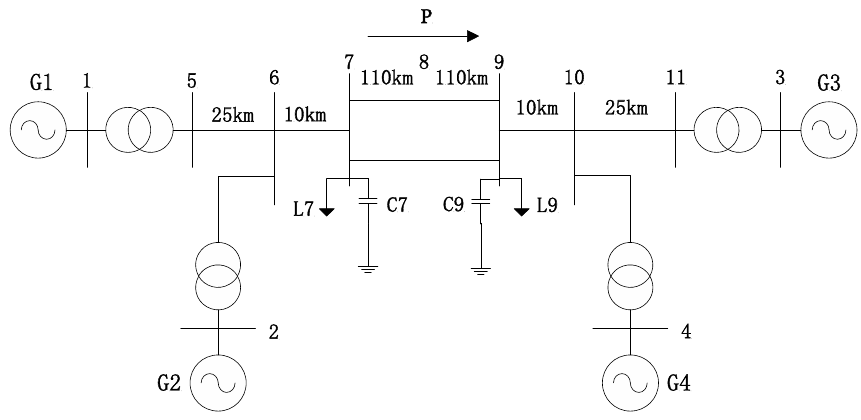
Figure 2. Power system with four machines in two areas. Table 1. The results of modal analysis in a power system without a controller. Mode No. Mode Type Frequency (Hz) Damping Ratio The open-loop system, where the local controller is not concluded, is of 76 orders and the reduced-order system is obtained by the Schur balanced truncation reduction technique. The frequency responses of a system with 76 orders, 9 orders and 8, orders are presented in Figure 3, and they are very close, over 0.1 Hz – 2.5 Hz. Hence, the 8 th order system model is used for the simulation.